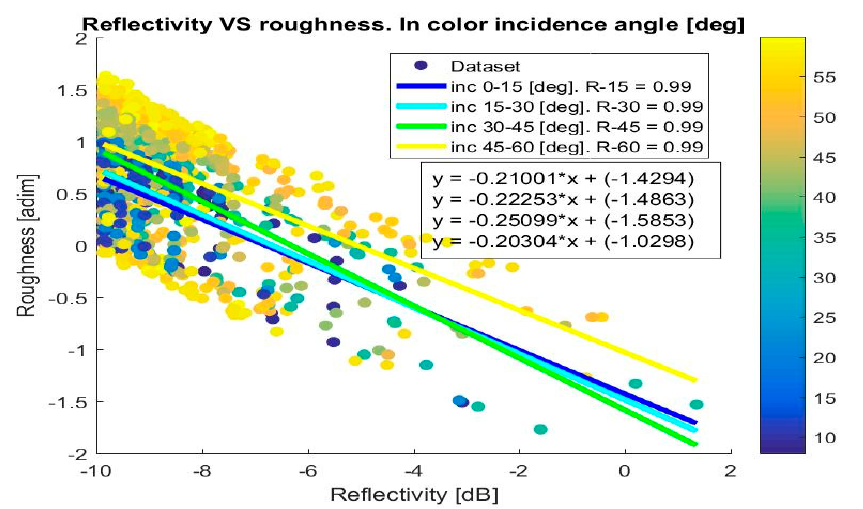
Figure 14. Reflectivity [dB] and ad hoc surface roughness compensation for different incidence angles.